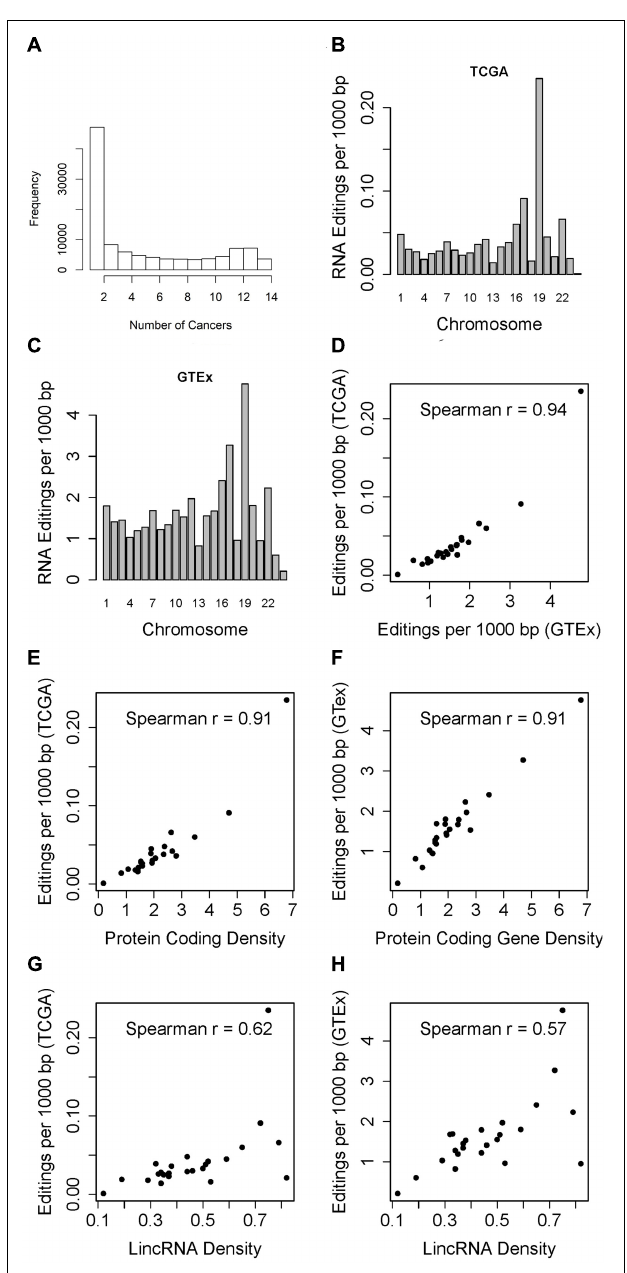
FIGURE 1 | (A) Histogram which displays the number of times RNA editing positions have been observed in the 14 cancer types. Majority of the RNA editing positions were observed in one cancer type. (B) Barplot which shows the RNA editing rate in TCGA (RNA editing events per 1000 bp) by chromosome. The RNA editing rate is adjusted for the chromosome length. Chromosome 19 had the highest RNA editing rate. (C) Barplot which shows the RNA editing rate in GTEx chromosome. The RNA editing rate is adjusted for the chromosome length. Similar to GTEx results, chromosome 19 had the highest RNA editing rate. (D) Scatter plot of overall RNA editing rates by chromosome between TCGA and GTEx by chromosome. (E) Scatter plot of TCGA RNA editing rate and gene density by chromosome. (F) Scatter plot of GTEx RNA editing rate and gene density by chromosome. (G) Scatter plot of TCGA RNA editing rate and lincRNA density by chromosome. (H) Scatter plot of GTEx RNA editing rate and lincRNA density by